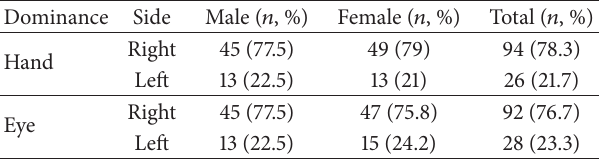
Table 1: The distribution of gender and eye and hand dominance.